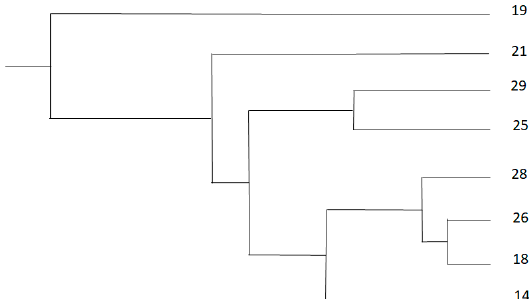
Figure 1. Cluster analysis of lambs experimentally infected with Spanish goat encephalitis virus (SGEV) in terms of lesion severity using the centroid method in the SAS CLUSTER procedure. Lambs 19, 21, 25, and 29 were assigned to cluster A (mild to moderate lesions), while lambs 14, 18, 26, and 28 were assigned to cluster B (moderate to severe lesions). A general linear model was constructed using the GLM procedure in SAS with the following dependent variables: arcsin-transformed proportions of microglia, T lymphocytes, and B lymphocytes; log-transformed semi-quantitative scores for astrocytes; and proportion of total stained area that was positive for Iba1. The independent variables were: CNS region, type of lesion (perivascular cuffing or glial foci), cluster, and their first-order interactions. Pairwise least-square means comparisons were carried out using Student’s t test as implemented in the LSMEANS statement in SAS. Statistical significance was accepted at p < 0.05, while p = 0.05–0.1 was taken to indicate a tendency [6]. Potential differences in the number of lesions (glial foci) between the infected side of the animal and the opposite side (laterality effects) were examined using the chi-squared test in the FREQ procedure in SAS and confirmed using the log-transformed foci counts submitted to analysis of variance of the generalized linear model. Laterality effects were also confirmed using a least-squares mean Student’s t test with the LSMEANS statement in a model with three independent variables: cluster, side, and their interaction